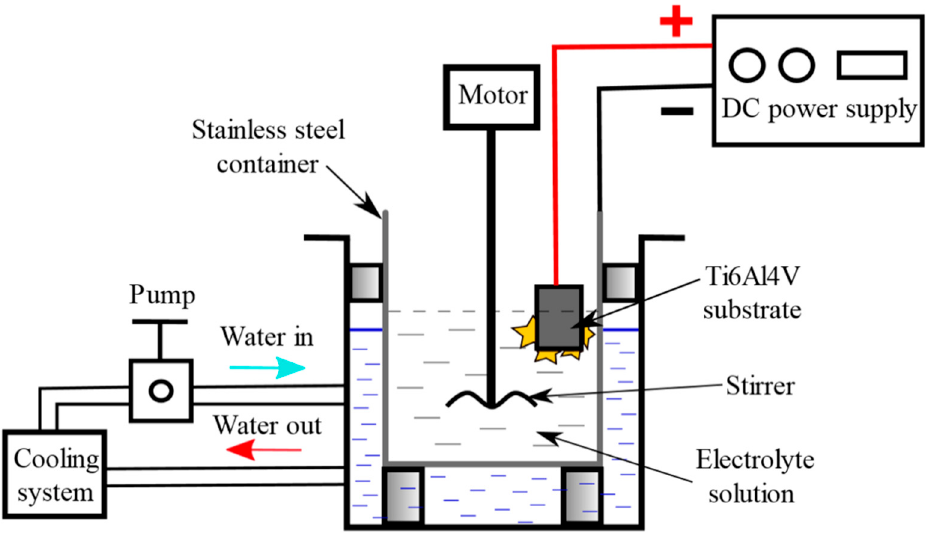
Figure 1. Plasma electrolytic oxidation setup.